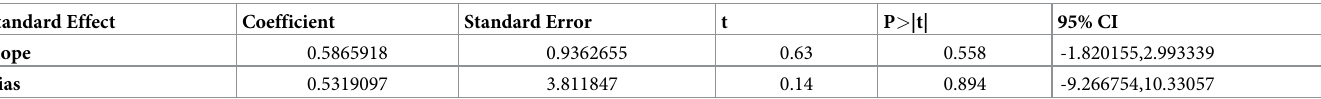
Table 2. Egger’s test for small-study